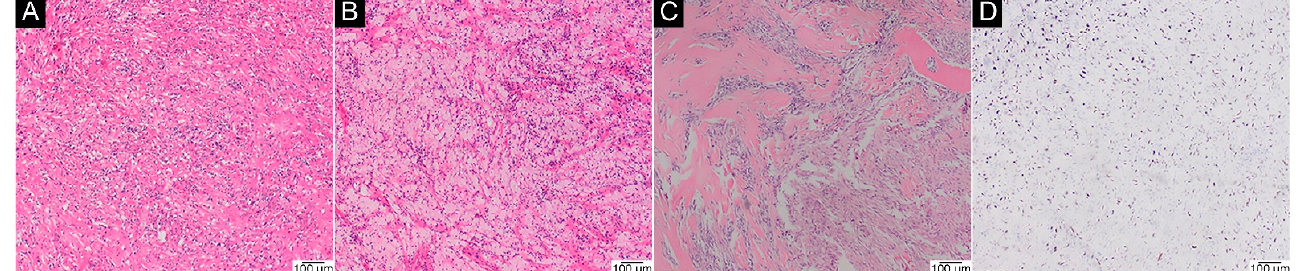
Figure 5. GCTB after denosumab treatment. ( A ) stromal fibrosis (H&E, 40×); ( B ) scattered inflammatory infiltrates comprising foamy macrophages and lymphocytes (H&E, 40×); ( C ) spindle mononuclear cells resembling fibroblasts without osteoclast-like giant cells, with ossification (upper right corner) (H&E, 40×); ( D ) IHC assay on the same specimen (anti - histone H3.3 G34W Ab, 40×) .